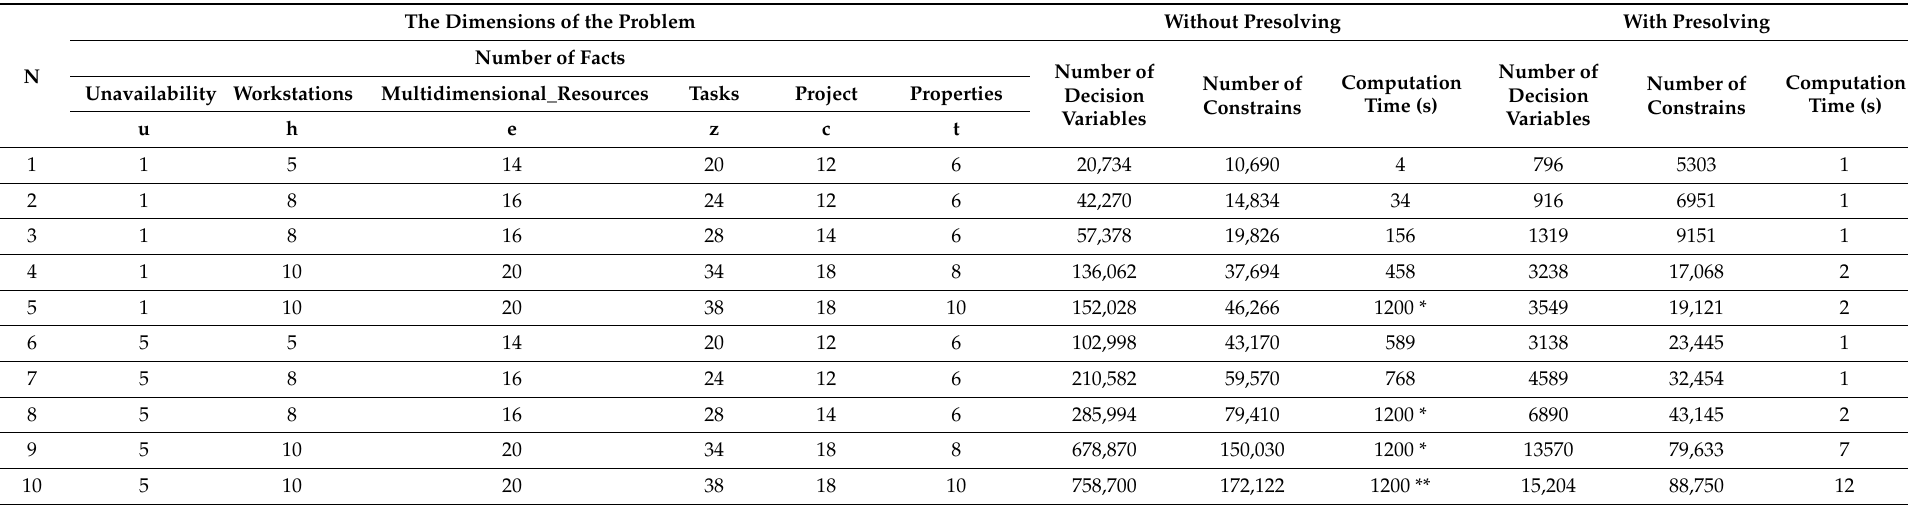
Table 7. Answers for Q4 (1–5) and Q5 (6–10) for different data